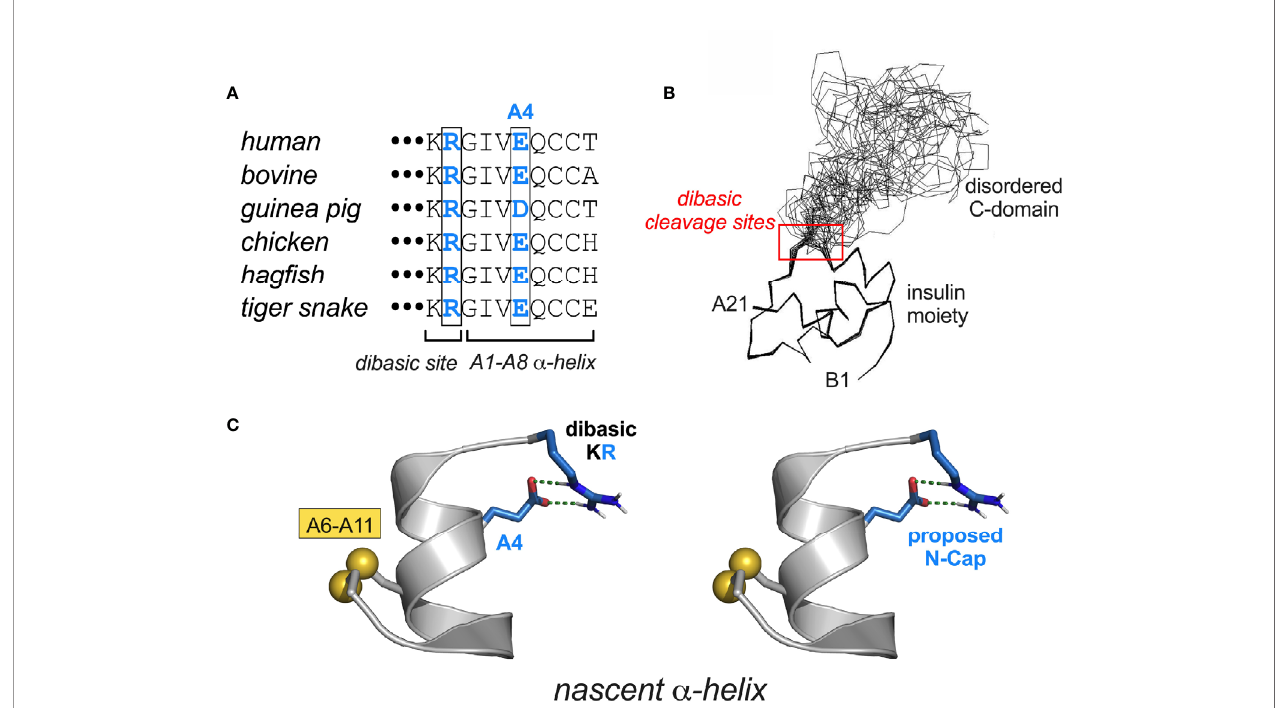
FIGURE 7 | MIDY-related mutations at CA junction. (A) Vertebrate sequence alignment showing conserved KR dibasic site (CA junction) and acidic side chain at residue A4. (B) Solution structure of proinsulin (line drawing) showing the folded insulin moiety and disordered C-domain (48). The dibasic RR (BC junction) and KR sites (CA junction) are within red box. (C) Proposed stabilization of a nascent a -helix in proinsulin folding intermediate by junctional ( i , i +4) salt bridge between residues Arg and Glu A4 (blue in panels A , C ). The putative salt bridge was modeled as an a -helical N-Cap element (177) using